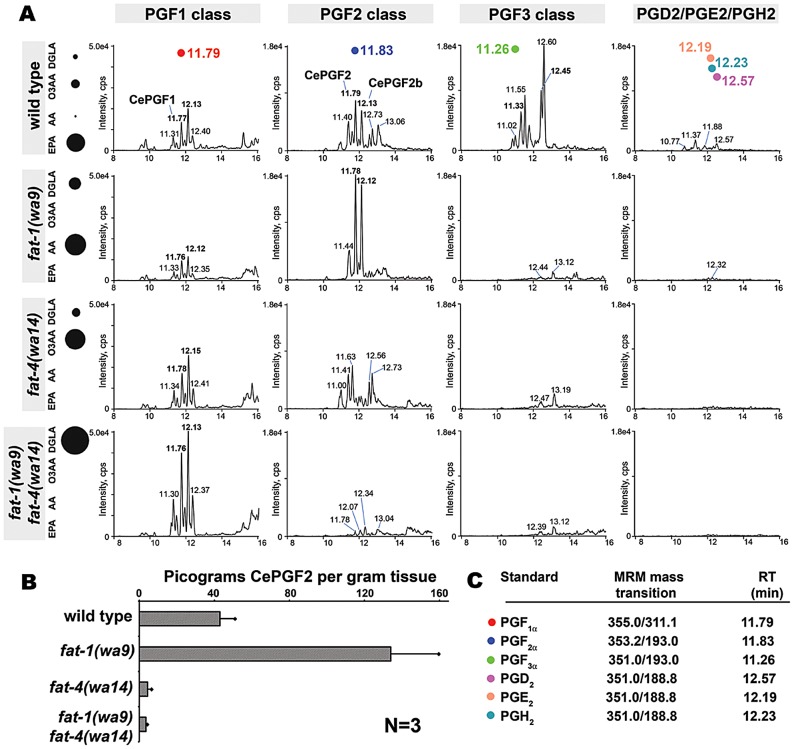
Prostaglandins in wild-type and fat mutant extracts.(A) MRM chromatograms of wild-type and fat mutant extracts. Liquid chromatography retention time (min) is shown on the X-axis and for selected prostaglandin isomers. Bolded retention times indicate prostaglandin isomers shown in Figure 4. Prostaglandin standard retention times are shown at the top. The dot diagram to the left indicates relative PUFA levels in the corresponding strains [33]. DGLA, dihomo-γ-linolenic acid; O3AA, omega-3 arachidonic acid; AA, arachidonic acid; EPA, eicosapentaenoic acid; cps, counts per second. (B) CePGF2 quantification in wild-type and fat mutant extracts. Error bars are SD. (C) Summary of MRM mass transitions and retention times for chemically synthesized standards. RT, retention time.